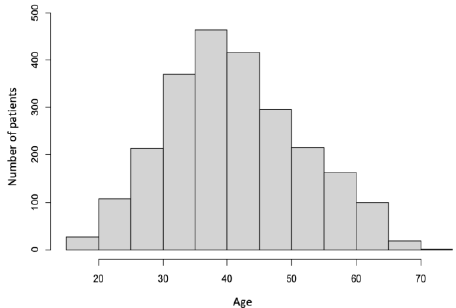
Figure 1. Age structure of the study group.